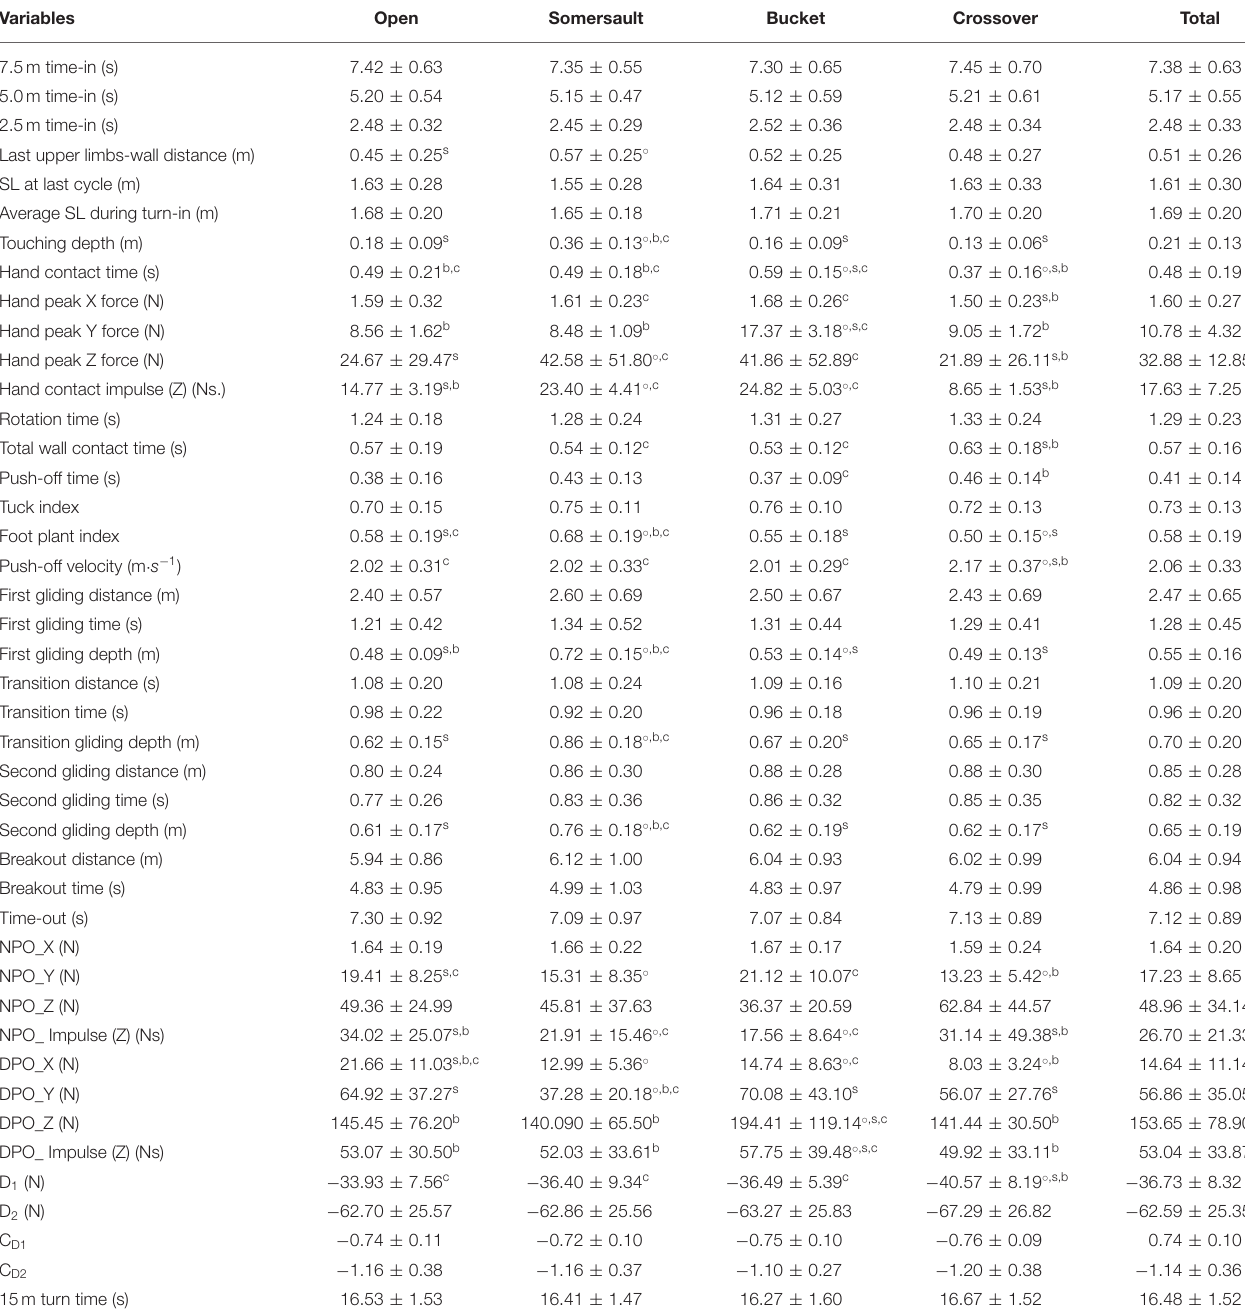
TABLE 3 | Descriptive- and variance-related statistics of the studied variables.